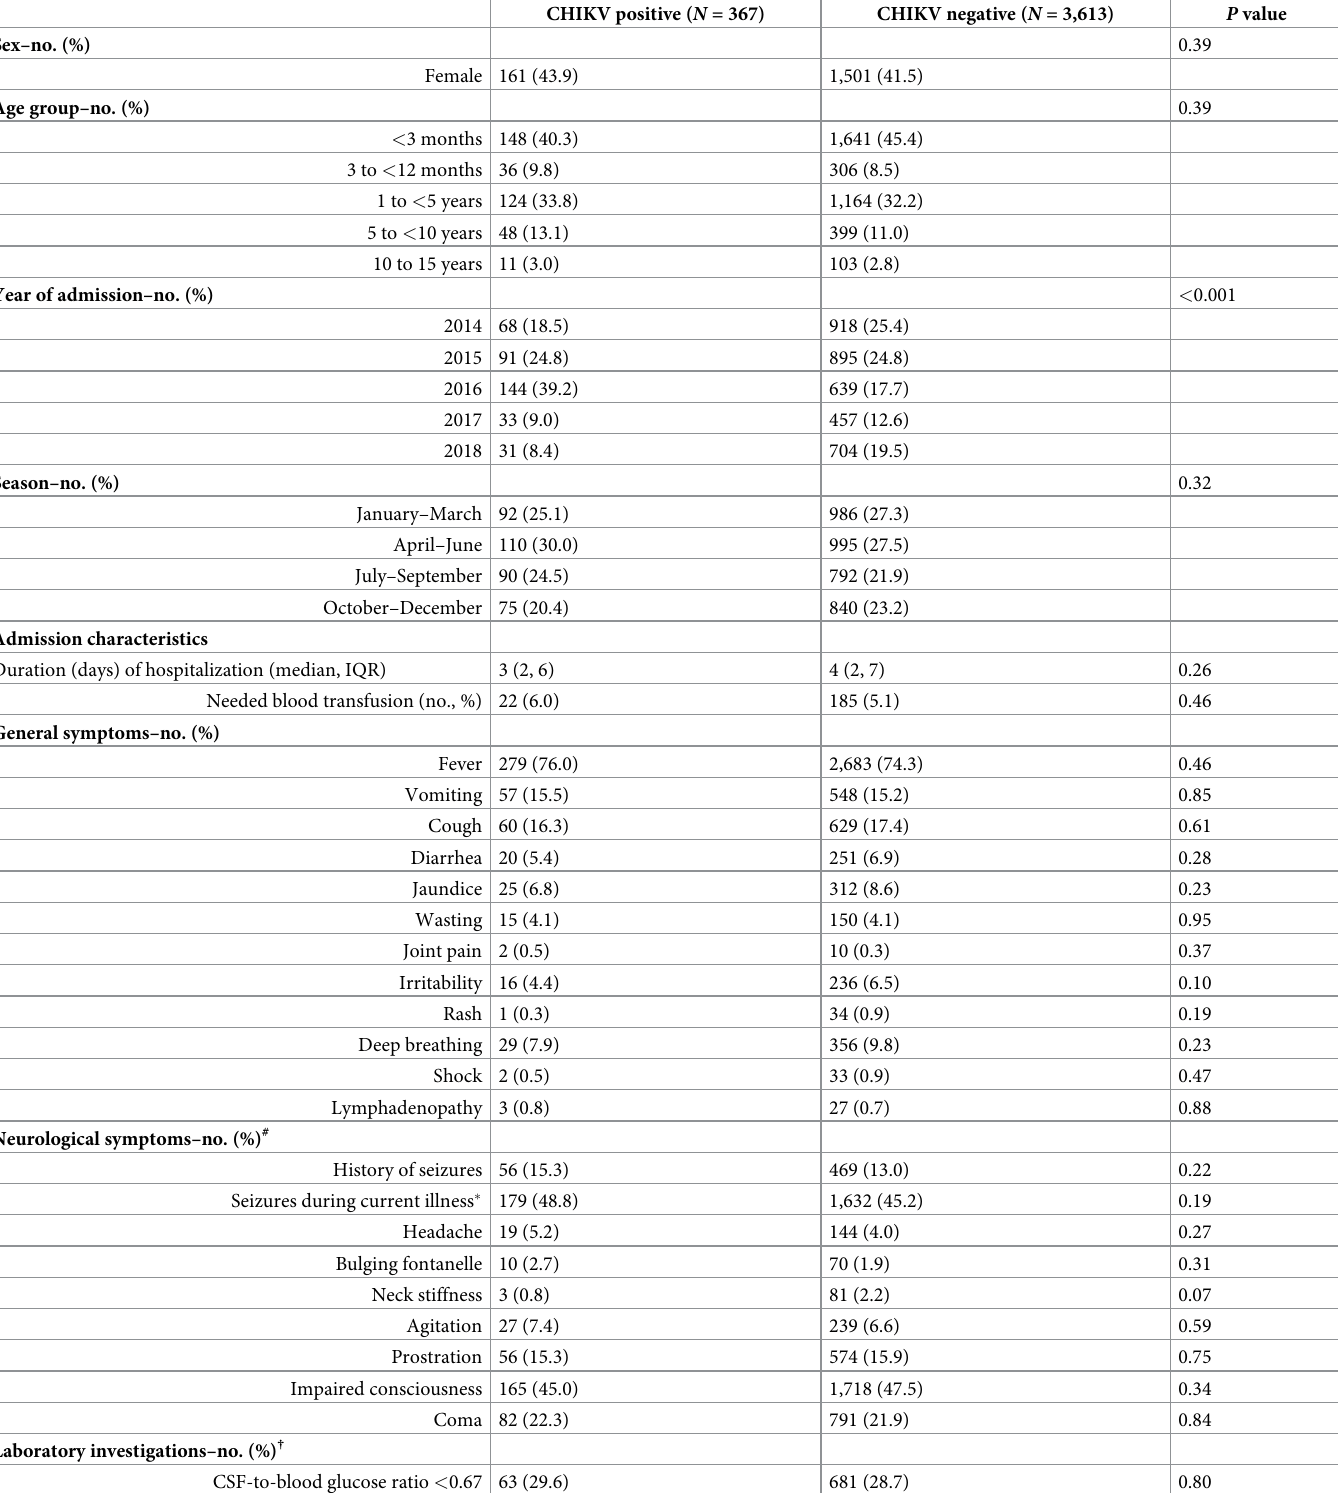
Table 1. Demographic and clinical features of patients screened for CHIKV